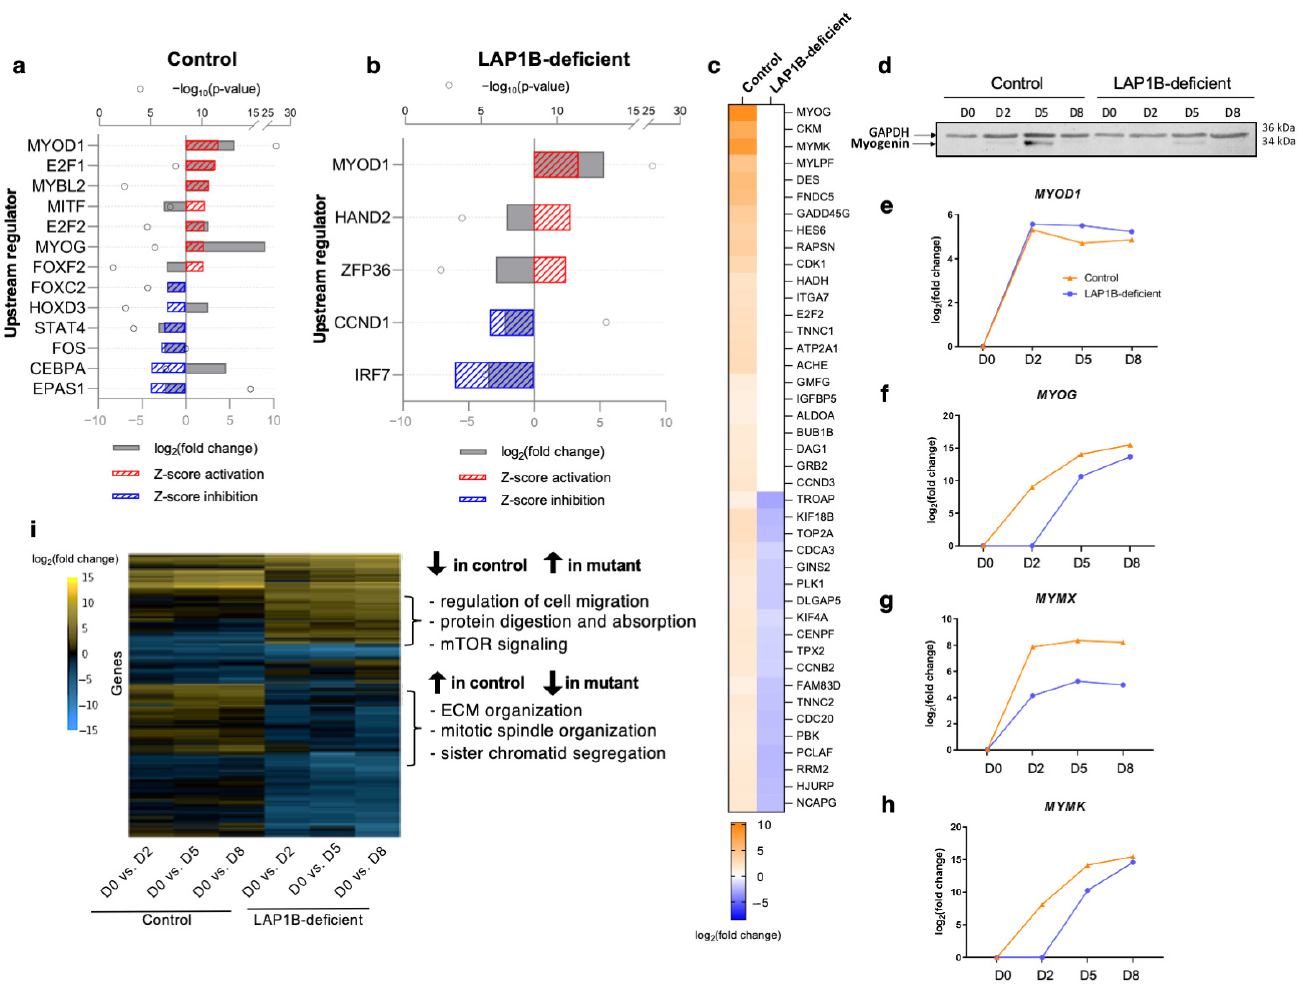
Figure 5. Upstream regulator and time-course regression analyses. ( a , b ) Upstream transcription regulators were predicted to be affected in the ( a ) control and ( b ) LAP1B-deficient cells during the transition from day 0 to day 2 of differentiation using Ingenuity Pathway Analysis. The upper X-axis shows − log 10 of p -values (circles) for each upstream regulator. The lower X-axis shows log 2 of expression fold changes (grey bars) and predicted transcriptional activation Z-scores (dashed red bars show activation, i.e., z-score > 2; dashed blue bars show inhibition, i.e., z-score < − 2). ( c ) Heat map showing expression fold changes of DEGs in the MyoD network during the day 0–day 2 transition in the control and LAP1B-deficient cells. Genes that are upregulated in the controls, and downregulated or unchanged in the LAP1B-deficient cells are displayed. ( d ) Protein expression of myogenin in the control and LAP1B-deficient cells at days 0, 2, 5, and 8 of differentiation; GAPDH was used as a loading control. ( e – h ) RNA expression fold changes of ( e ) MYOD1 , ( f ) MYOG , ( g ) MYMX, and ( h ) MYMK throughout differentiation as determined using RNA-Seq. ( i ) Clustered heat map showing expression fold changes of DEGs identified using time-course regression analysis. The top three enriched GO and KEGG categories for DEGs with opposite expression trends in the control and LAP1B-deficient cells throughout differentiation are